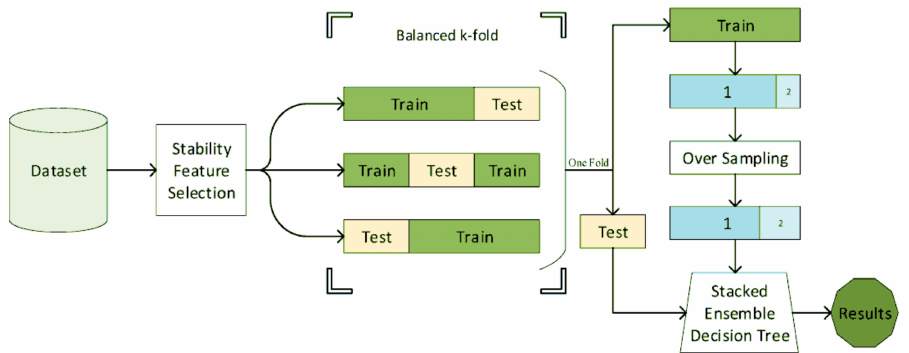
Figure 7. The block diagram of the suicide diagnosis algorithm. The features are first selected using stability feature selection. Using the stratified sampling, the features are then classified using a stacked ensemble decision tree (reproduced with permission from